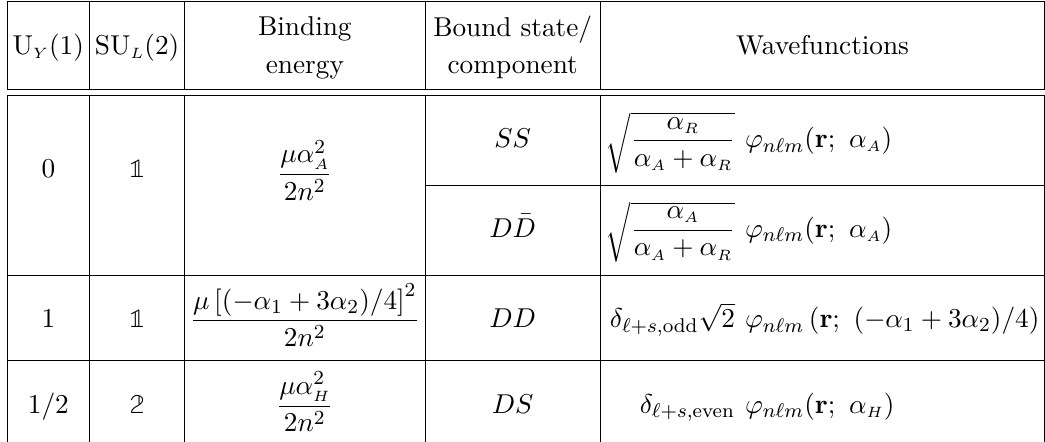
Table 4 . The bound states and their wavefunctions in the limit m the bound state wavefunction with quantum numbers { n‘m } for a Coulomb potential V ( r ) = − α/r . The couplings α and α are defined in eqs. (2.25), and depend on ‘ + s . For ‘ + s = odd, the ( 1 , 0 ) A R state becomes purely D ¯ D